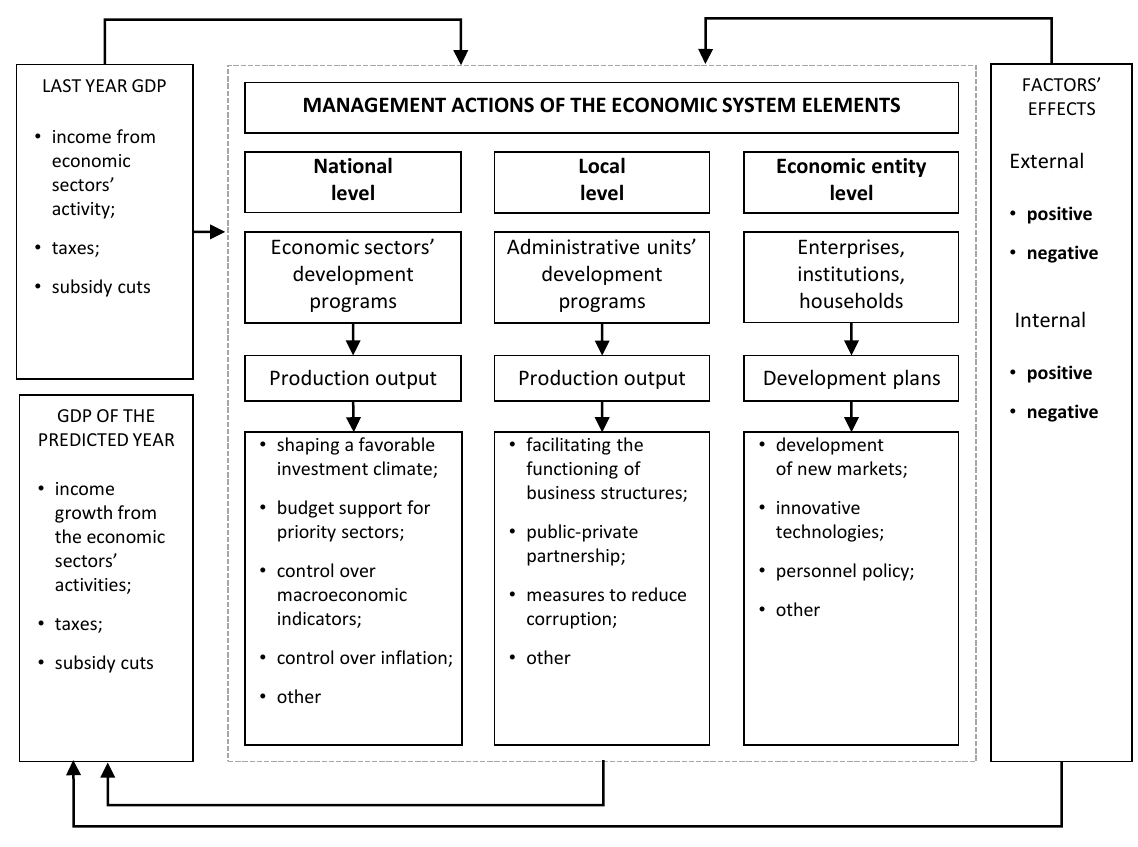
Figure 6. Logic and structural model for GDP